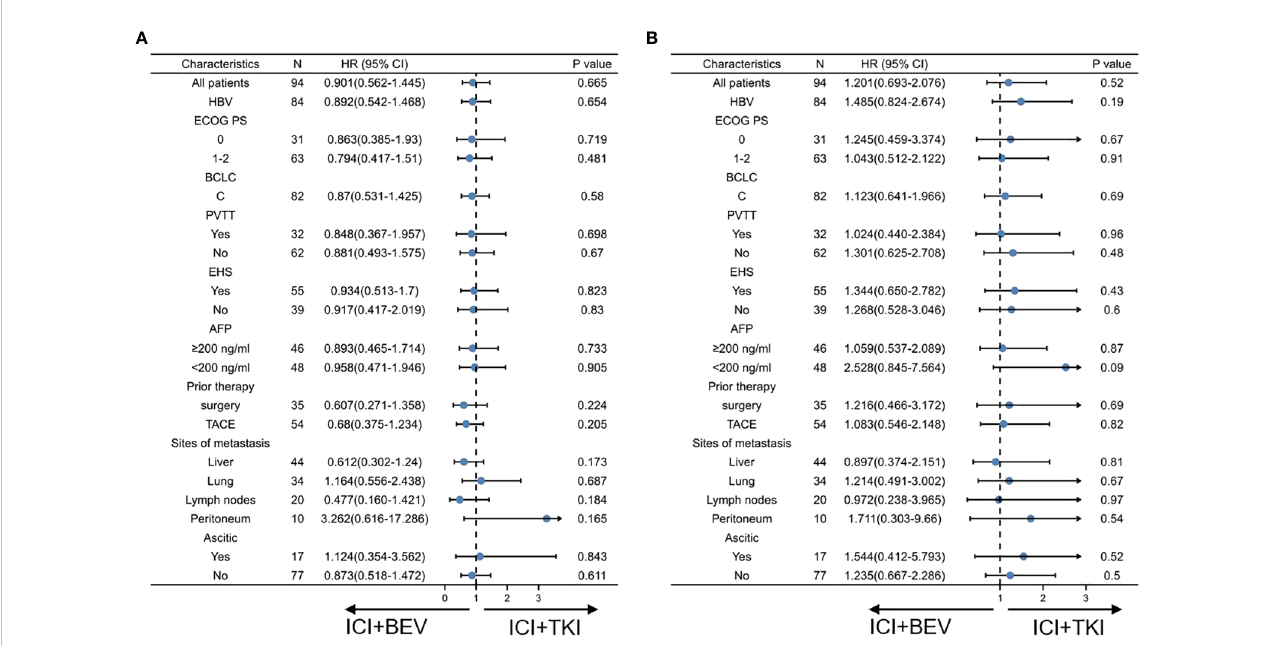
FIGURE 3 Subgroup analysis of progression-free survival and overall survival in intention-to-treat population at fi nal analysis. (A) Progression-free survival. (B) Overall